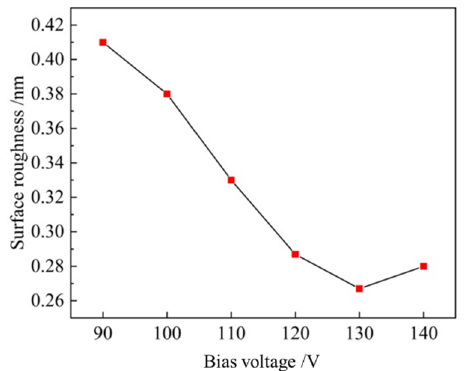
Figure 8. Surface roughness of Ta 2 O 5 films under different ion source bias. Table 3. Process parameters of the ion source for depositing Ta 2 O 5 and SiO 2. Table 3. Process parameters of the ion source for depositing Ta